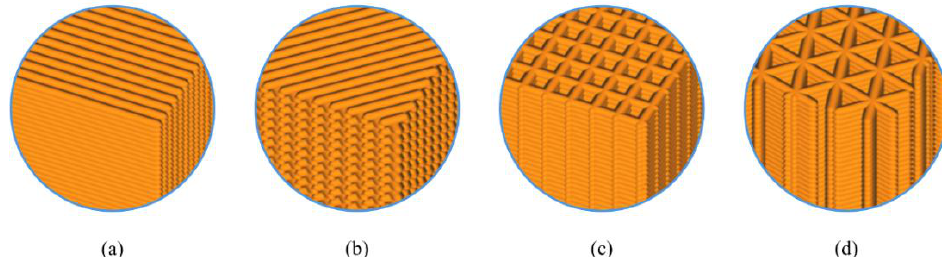
Figure 1. Illustration of different infill patterns with the highest infill density. From left to right, ( a ) lines, ( b ) cross, ( c ) cubic, and ( d ) triangles.